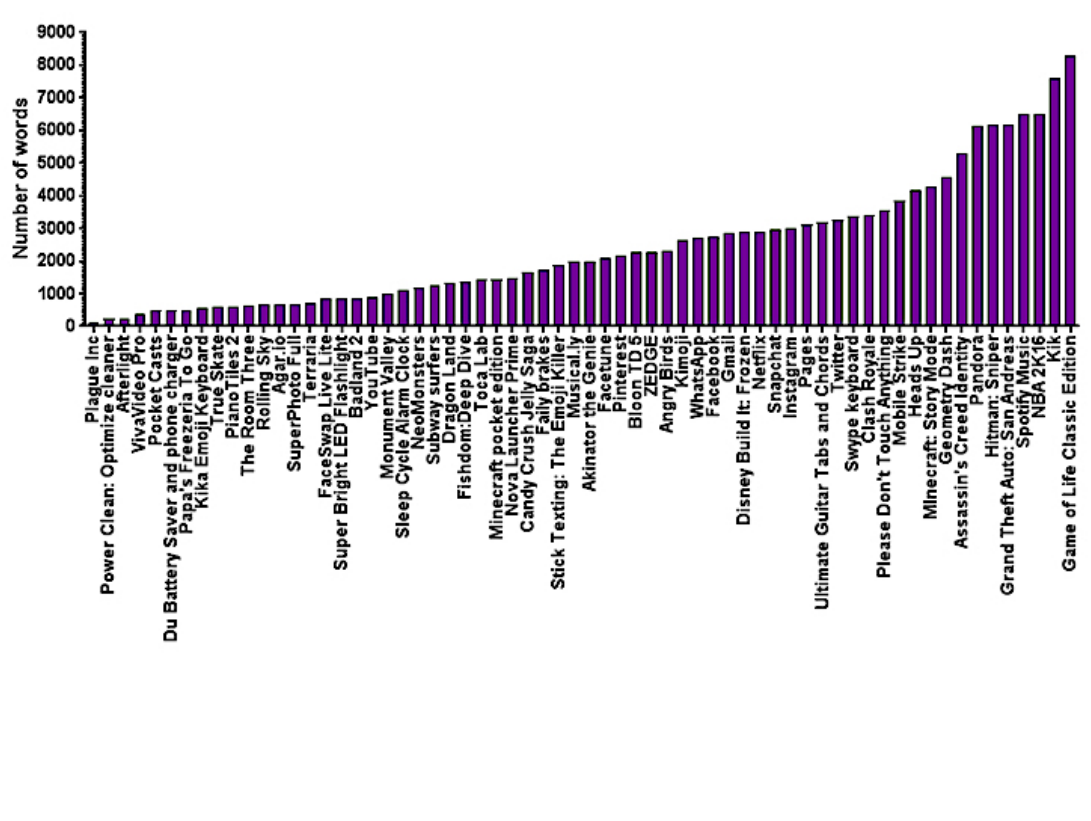
Figure 2. Privacy policy word count (N=64 apps). The average word count of the privacy policies was 2425 words. The Game of Life Classic Edition had the highest word count at 8290 words, and Plague Inc had the lowest word count at 140